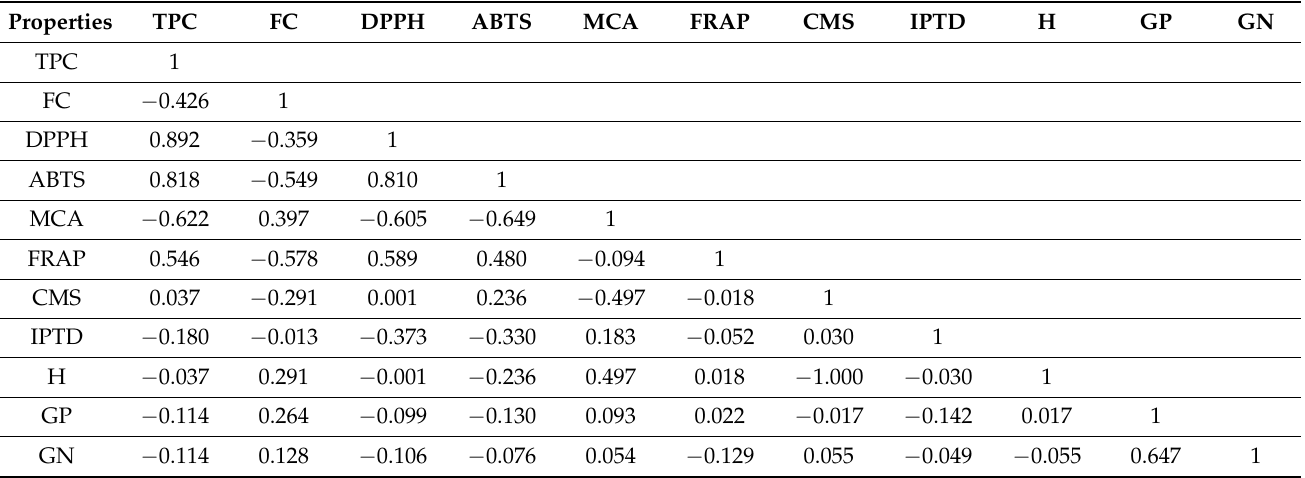
Table 3. Pearson correlation coefficients between various properties of propolis